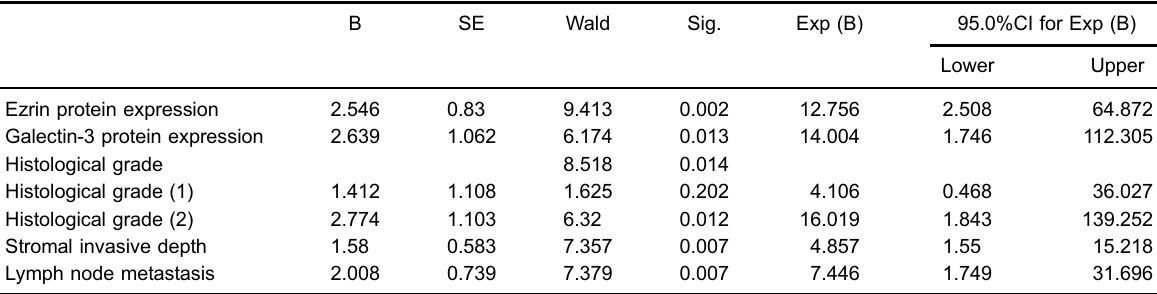
Table 5. Multivariate COX regression analysis of patients with cervical